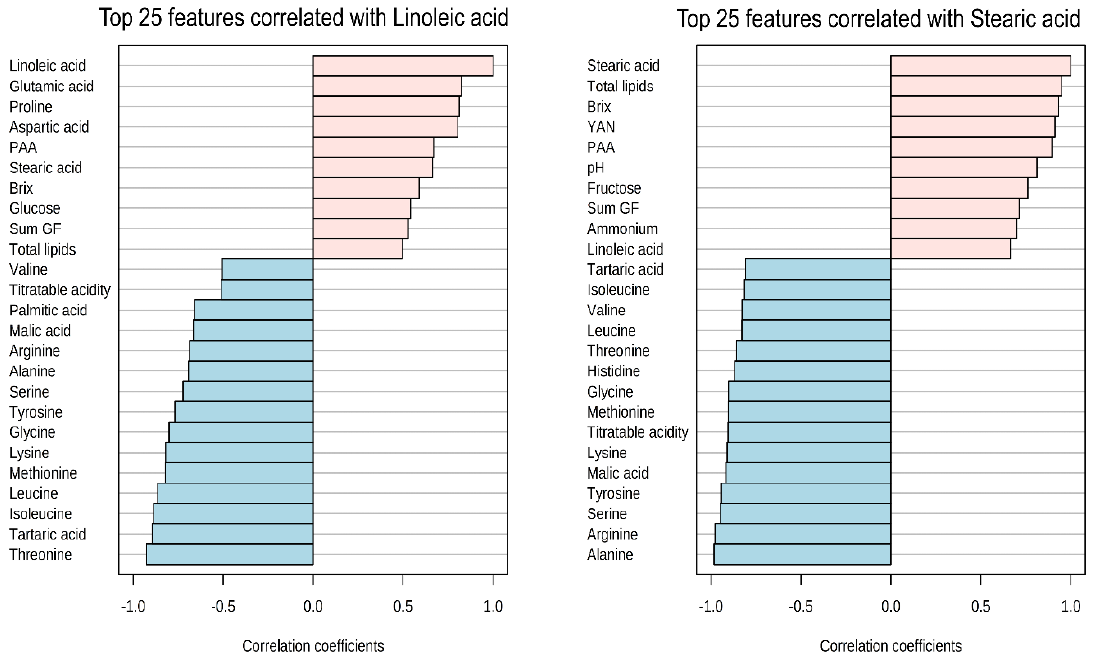
Figure 6. Pattern hunter plots showing the correlation of linoleic and stearic acids with different oenological parameters and nitrogenous compounds analyzed in the Sauvignon blanc and Pinot noir grape juices. Pink bars represent the positive correlation (Pearson r > +0.50) while blue bars show the negative correlation (Pearson r > − 0.50). YAN = yeast available nitrogen, PAA = primary amino acids, GF = glucose + fructose.